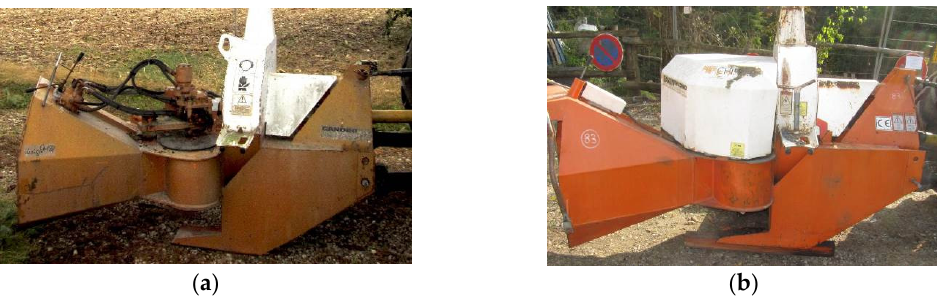
Figure 6. Specimens of the same model of wood chipper manufactured in different years on which lacked feeding area identification and safety pictorials were worn or incomplete. Moreover on ( a ) the hydraulic components are freely accessible while in ( b ) they are housed in a metal protection case.